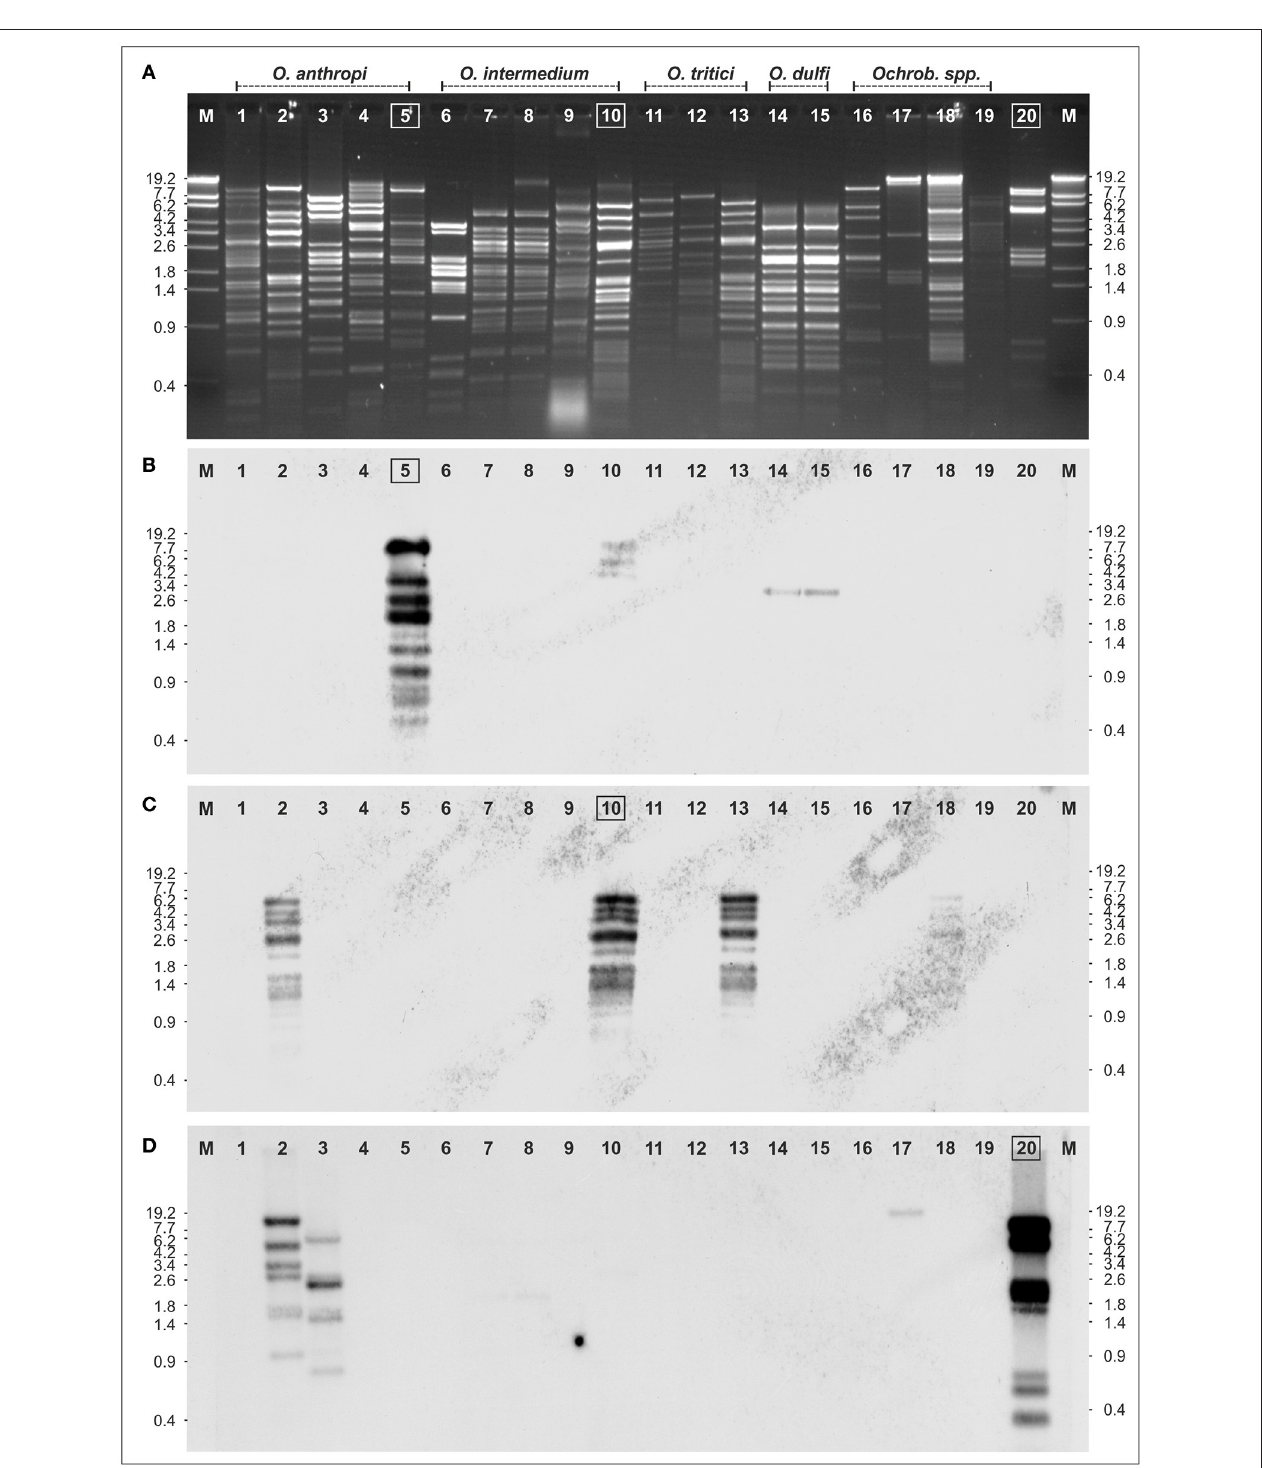
FIGURE 3 | Relationship of 19 Ochrobactrum spp. phages. (A) EcoRV restriction patterns of the phages. Southern hybridization of POA1180 (B) , POI1126 (C) , and BiPBO1 (D) to the isolated Ochrobactrum spp. phage DNAs: Ochrobactrum anthropi phages P1178 (lane 1), P1129 (lane 2), P1157 (lane 3), P1154 (lane 4), POA1180 (lane 5), O. intermedium phages: P1216 (lane 6), P1135 (lane 7), P1132 (lane 8), P1218 (lane 9), POA1126 (lane 10), O. tritici phages: P1114 (lane 11), P1184 (lane 12), P1187 (lane 13), O. dulfi phages: P1206 (lane 14), P1205 (lane 15), Ochrobactrum spp. phages: P1164 (lane 16), P1142 (lane 17), P1166 (lane 18), P1189 (lane 19), and Brucella inopinata phage BiPB01 (lane 20). Lanes M, Lambda Eco130I marker DNA.